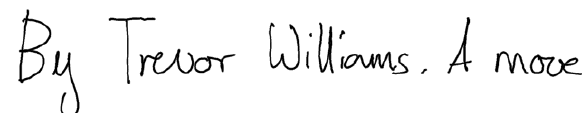
Figure 3. Sample of handwritten text of IAM online handwriting database.